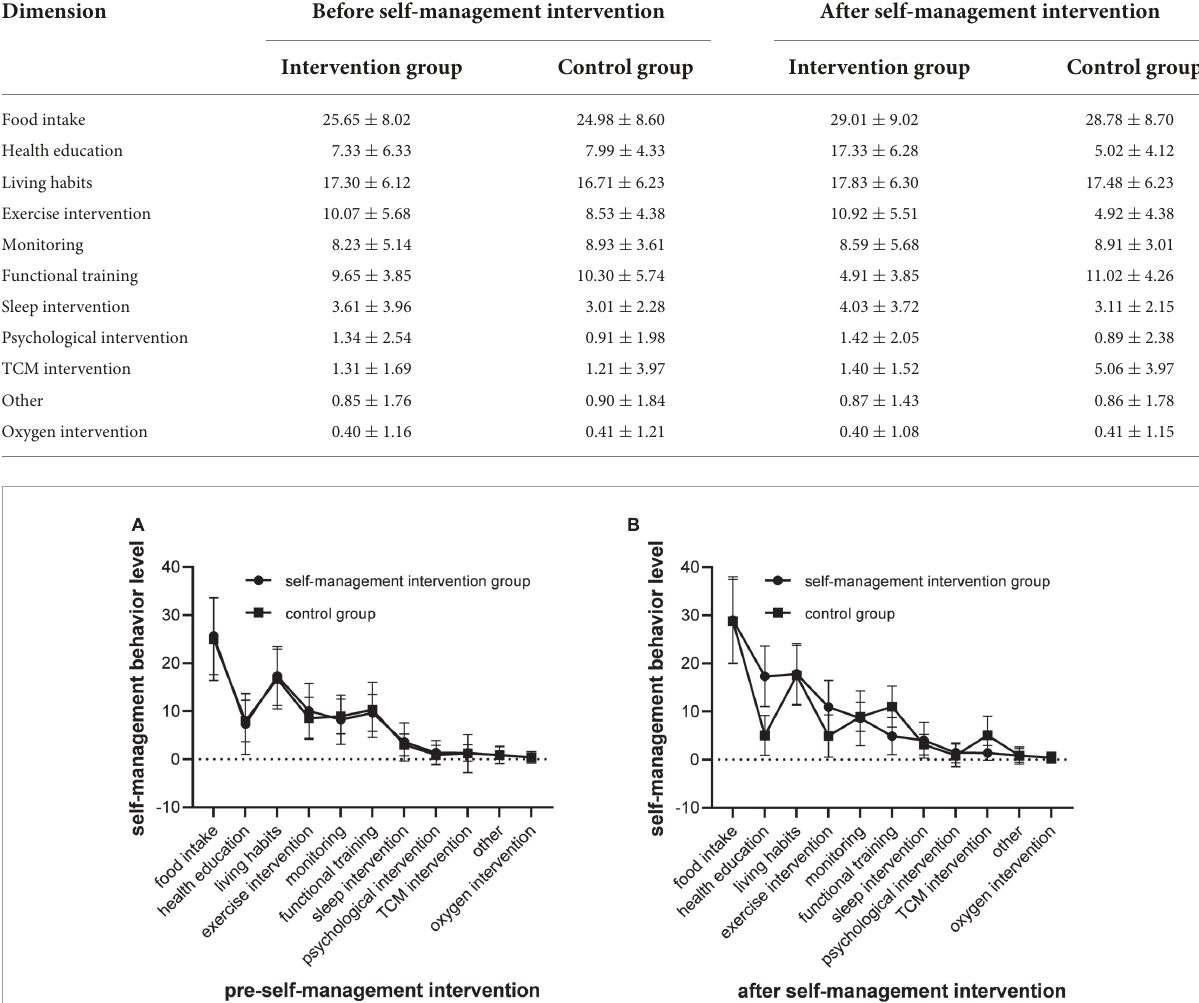
TABLE 4 Self-management behavior level and scores of the respective dimension in the self-management intervention group (x ± s). Dimension Before self-management intervention After self-management intervention Intervention group Control group Intervention group